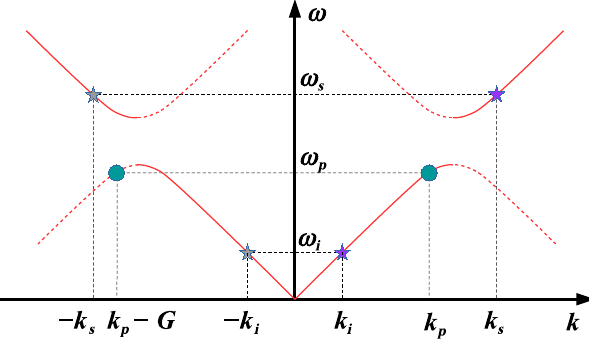
FIG. 9. A schematic view of the gapped dispersion (red curves, the dashed ones corresponding to folded dispersion) in the extended Brillouin zone picture. The green circles correspond to the two components of the pump wave with wave vectors − G < 0 , corresponding to the frequency ω k > 0 and k near p p p the gap edge. The purple stars represent signal and idler wave > 0 , corresponding to the frequencies ω , k , ω , while vectors k s i s i the gray stars represent − k , − k , corresponding to the same s i ≈ G= 2 , phase matching of k frequencies. For k , k with 2 k may p s i p − G Þ automatically yield phase matching of − k , − k with 2 ð k s i p leading to potentially dangerous backward amplification.